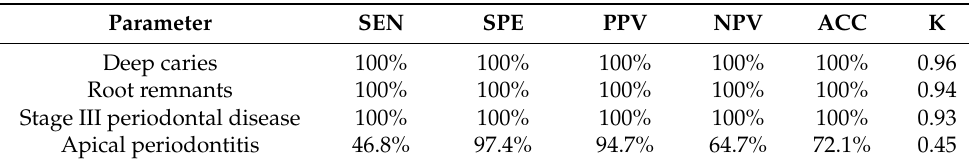
Table 2. Sensitivity (SEN), specificity (SPE), positive predictive value (PPV), negative predictive value (NPV), diagnostic accuracy (ACC) and Kappa Value for Panoramic Radiography in Relation to Multislice Spiral Computed